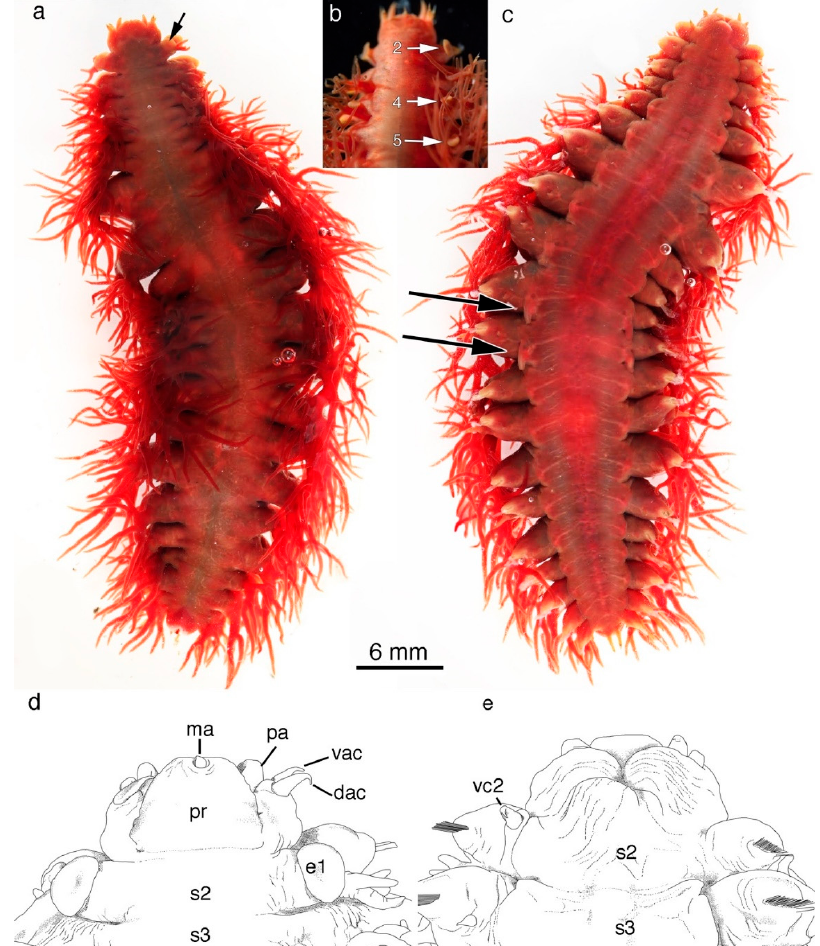
Figure 15. Branchipolynoe meridae n. sp. live female holotype (SIO-BIC A6616) and paratype (SIO-BIC A6529). ( a ) Dorsal view of holotype. Arrow indicates the very small elytron on segment 2. ( b ) Dorsal view of anterior of live paratype SIO-BIC A6529 showing small elytra on Segments 2, 4, and 5. ( c ) Ventral view of holotype. Arrows indicate elongated ventral papillae of Segments 11 and 12. ( d ) Drawing of dorsal anterior. ( e ) Drawing of ventral anterior. Abbreviations: pa, palps; ma, median antenna; pr, prostomium; e1, first elytron (attached on segment 2); s2 and s3, Segments 2 and 3; dac, dorsal anterior cirrus; vac, ventral anterior cirrus; vc2, ventral cirrus on segment 2.